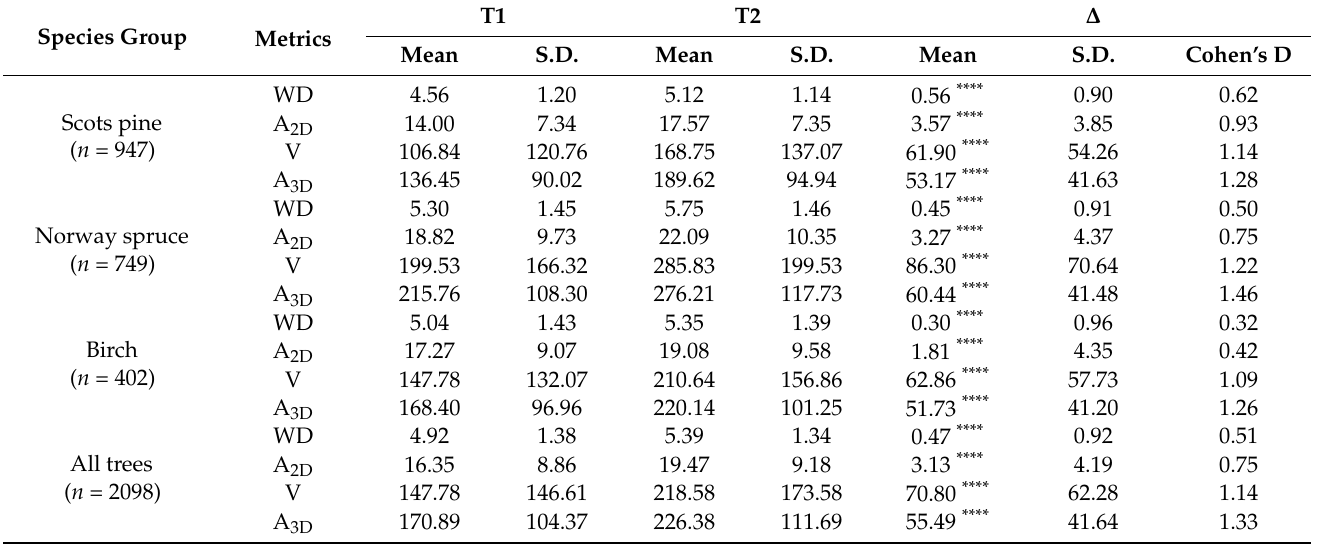
Table 4. T1 (2009) and T2 (2014) ALS-derived crown metrics of width (WD), projection area (A 2D ), volume (V), and surface area (A 3D ), and their growth ( ∆ ). The Mean, standard deviation (S.D.), and effect size (Cohen’s D) values are